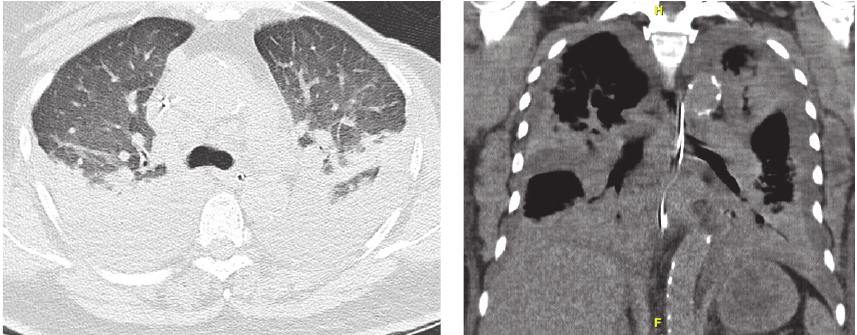
Figure 4: High resolution